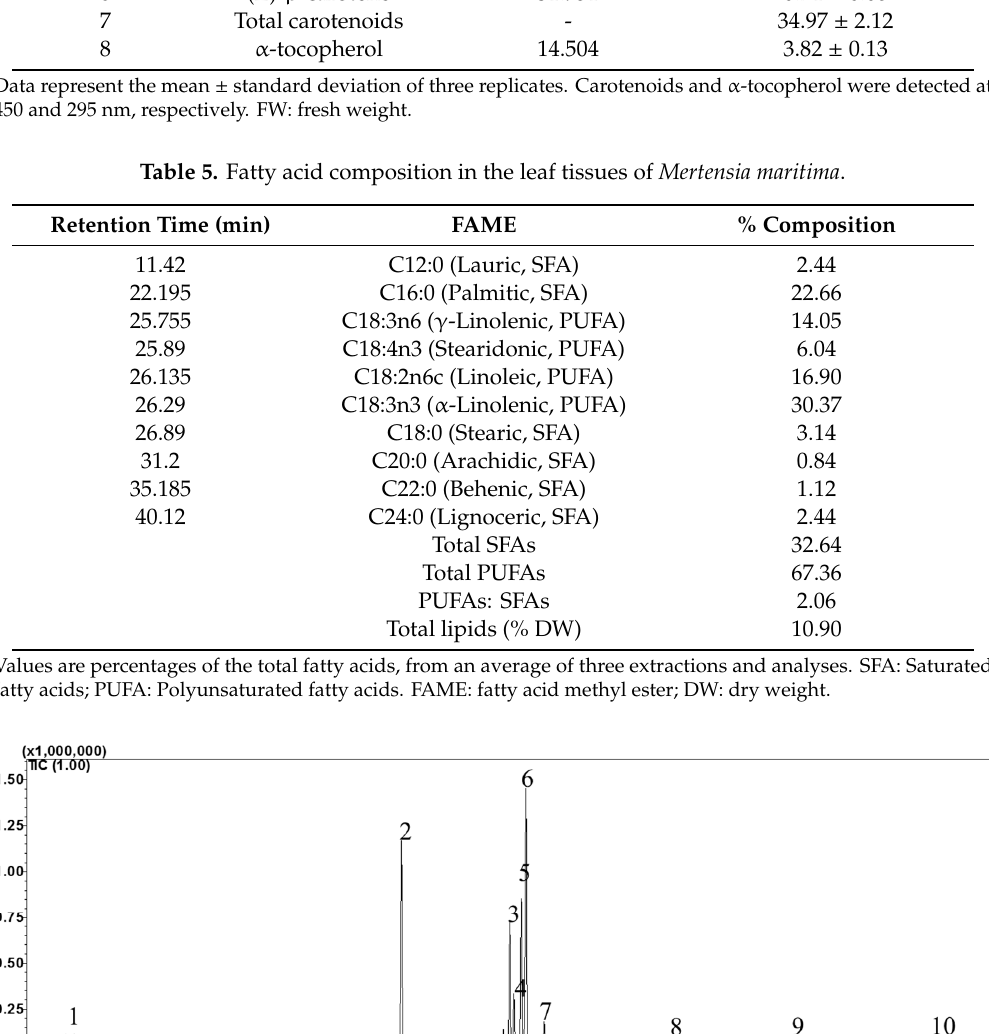
Table 5. Fatty acid composition in the leaf tissues of Mertensia maritima .